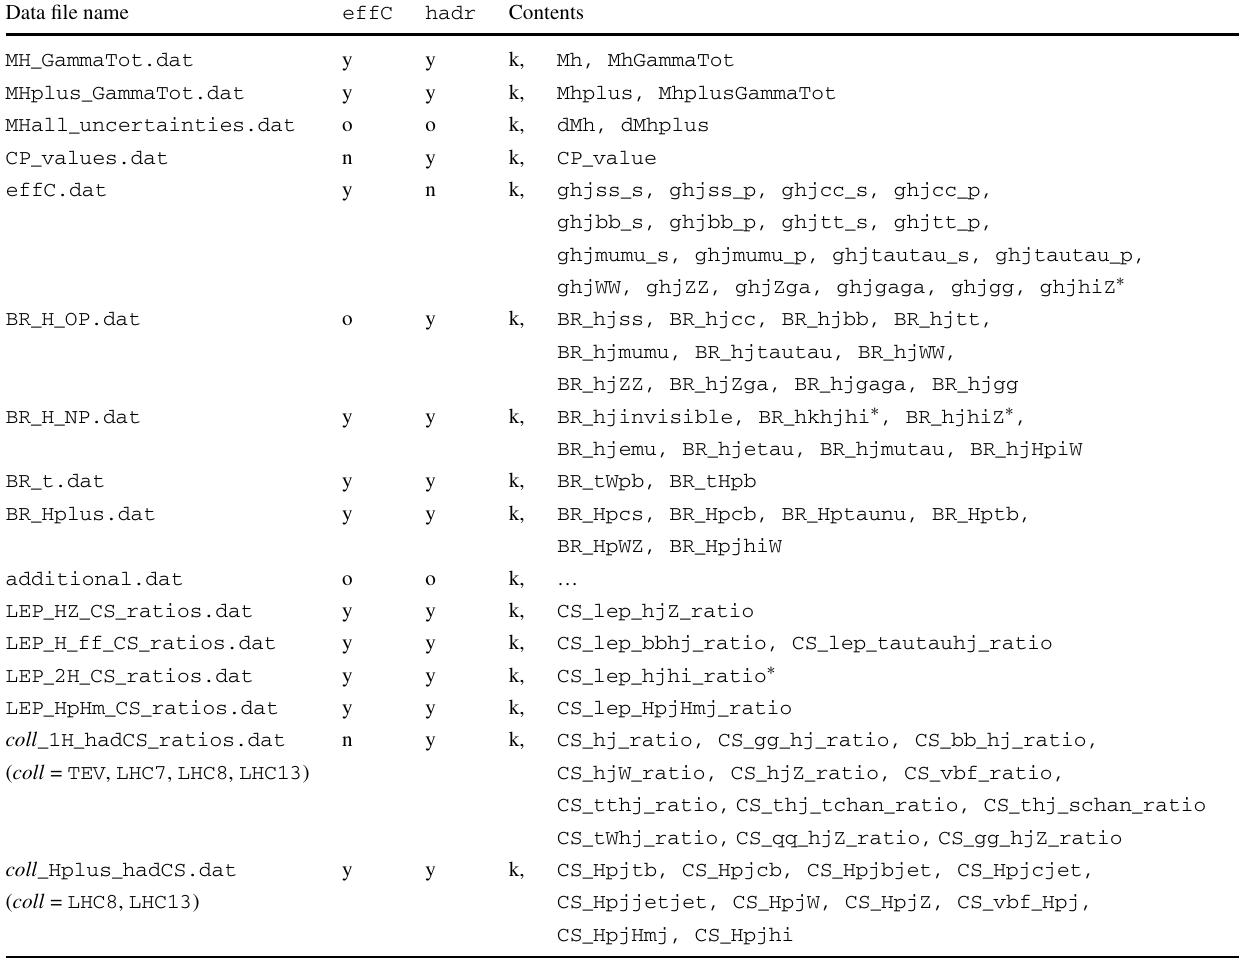
Table7 Filenamesanddataformatforthecontentsof HiggsBounds input files. The right column shows the order of the input data arrays within one row of the input file ( k is the line number). See the text for details on the order of elements within the arrays and the handling